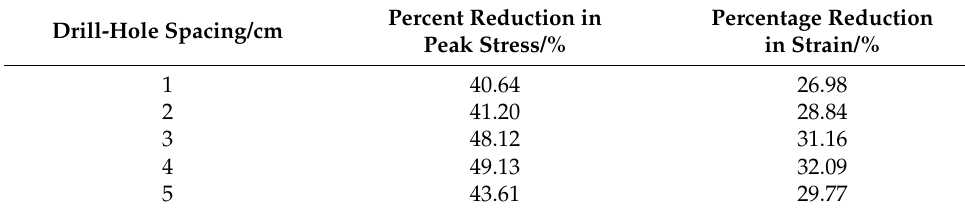
Table 4. Peak intensity and strain value decrease by percentage at peak intensity.